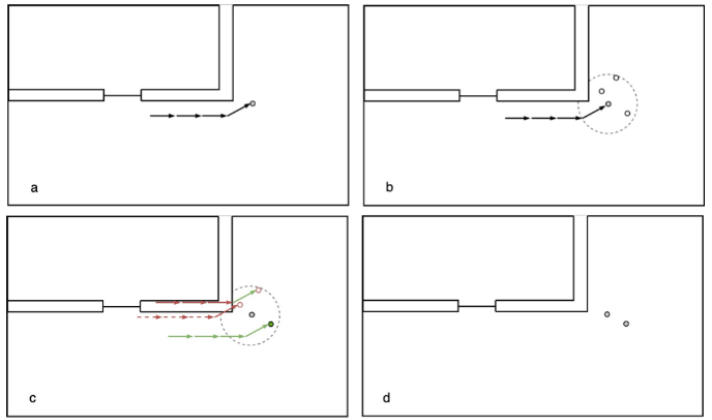
Figure 3. Overview of the backtracking process. A particle with valid trajectory is randomly cho- sen ( a ). Particles are randomly created in a specified radius ( b ). Newly created particles with invalid trajectories (red) are discarded until a particle with a valid trajectory (green) is found ( c ) and is accepted as a new particle ( d ).